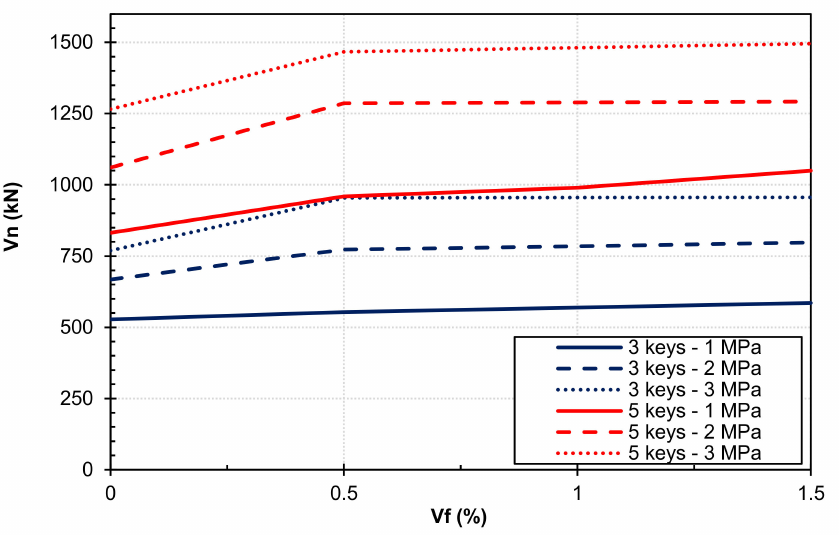
Figure 8. Nominal shear capacity in terms of V f and N k .